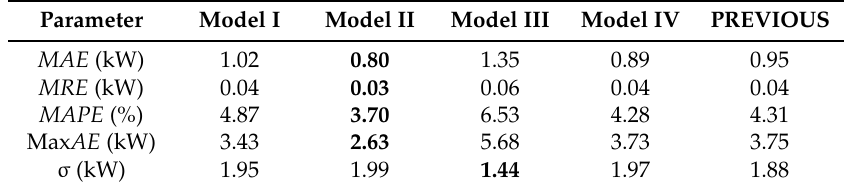
Table 17. Results obtained by MOGA and PREVIOUS models over Test F, for a PH of 1 h.